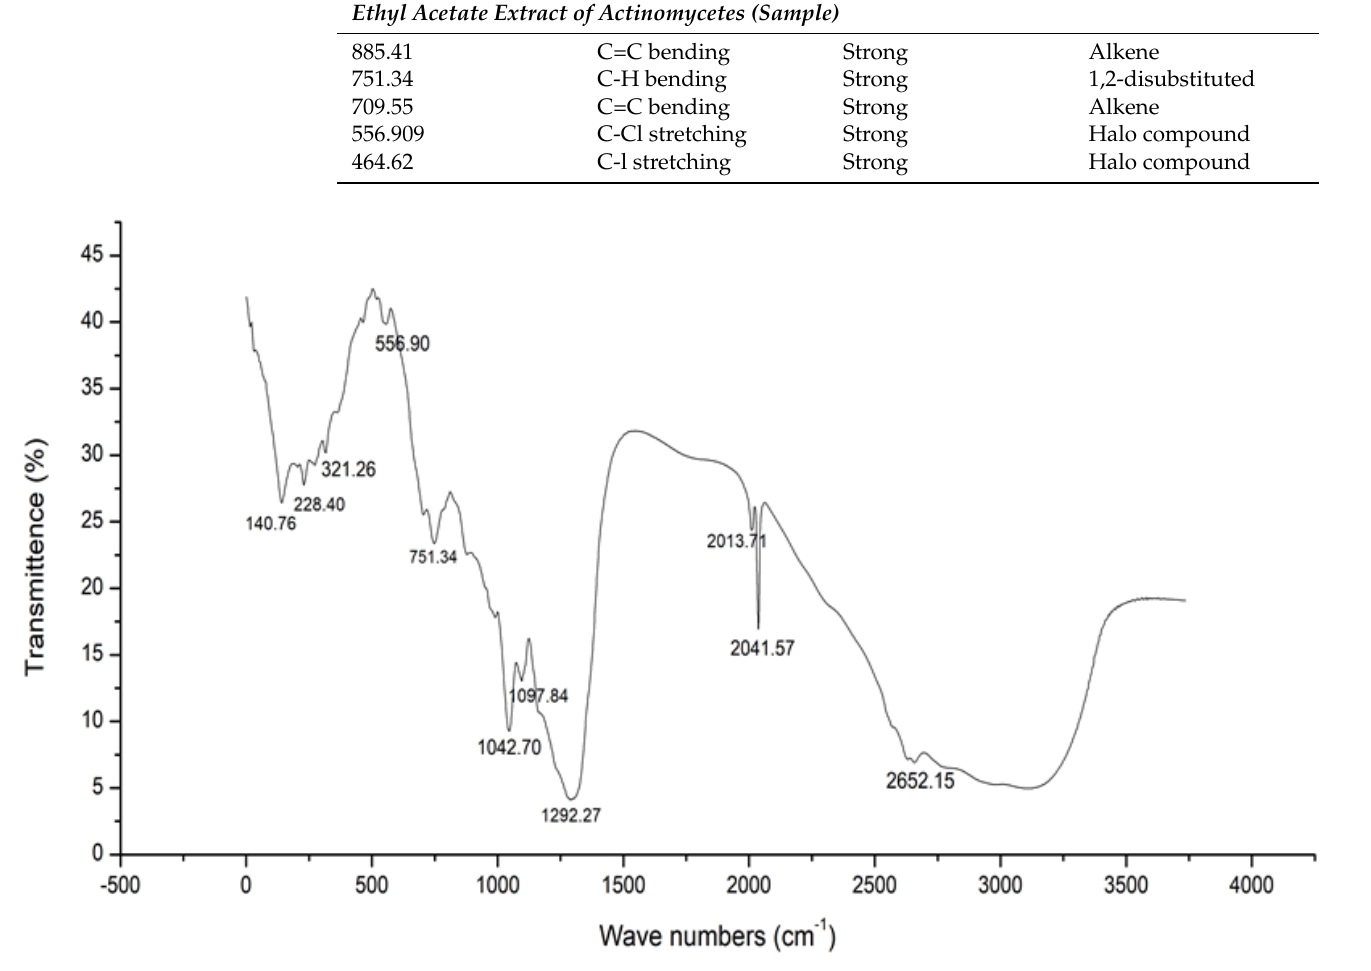
Figure 3. FTIR analysis of ethyl acetate extract of Beijerinickia fluminensis.